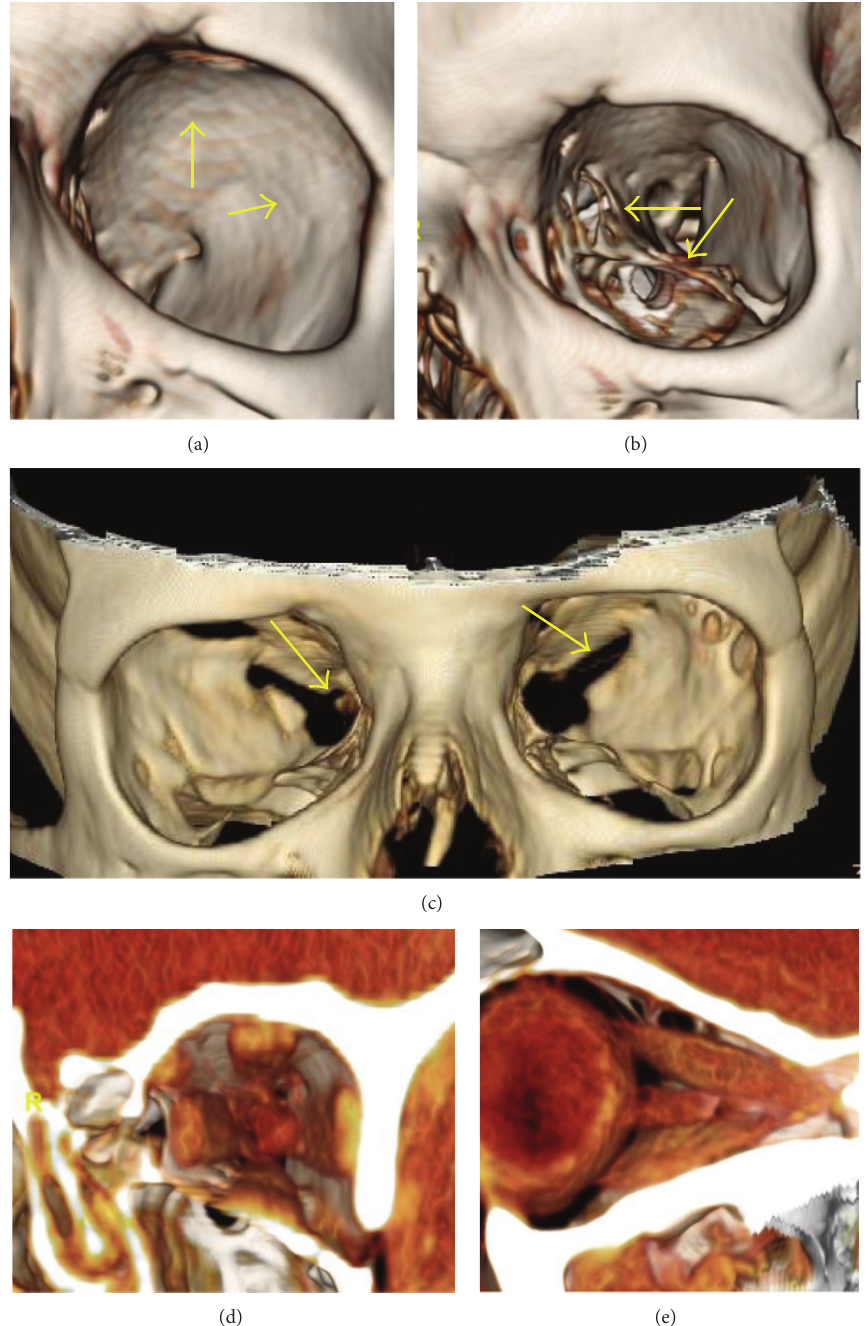
Figure 1: Normal anatomy of the bony orbit, globe, extraocular muscles, and optic nerve. (a) 3D image, bone window: smooth contour of the superior and lateral orbital walls (arrows). (b) 3D image, bone window: “spongiform” appearance of the lamina papyracea and orbital floor (arrows). (c) 3D image, bone window: demonstration of the optic canal and superior orbital fissure (arrows). ((d), (e)) 3D image, normal appearance of the extraocular muscles and optic